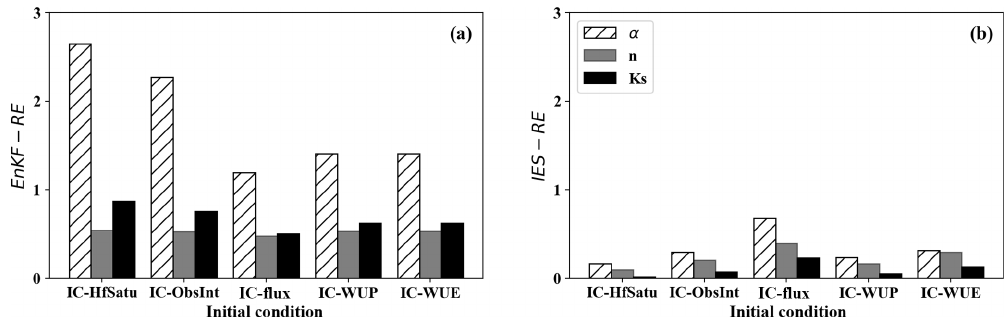
Figure 8. The RE results of parameter estimations ( α , n and K s ) under five initialization methods with (a) EnKF and (b) IES (Case 4).